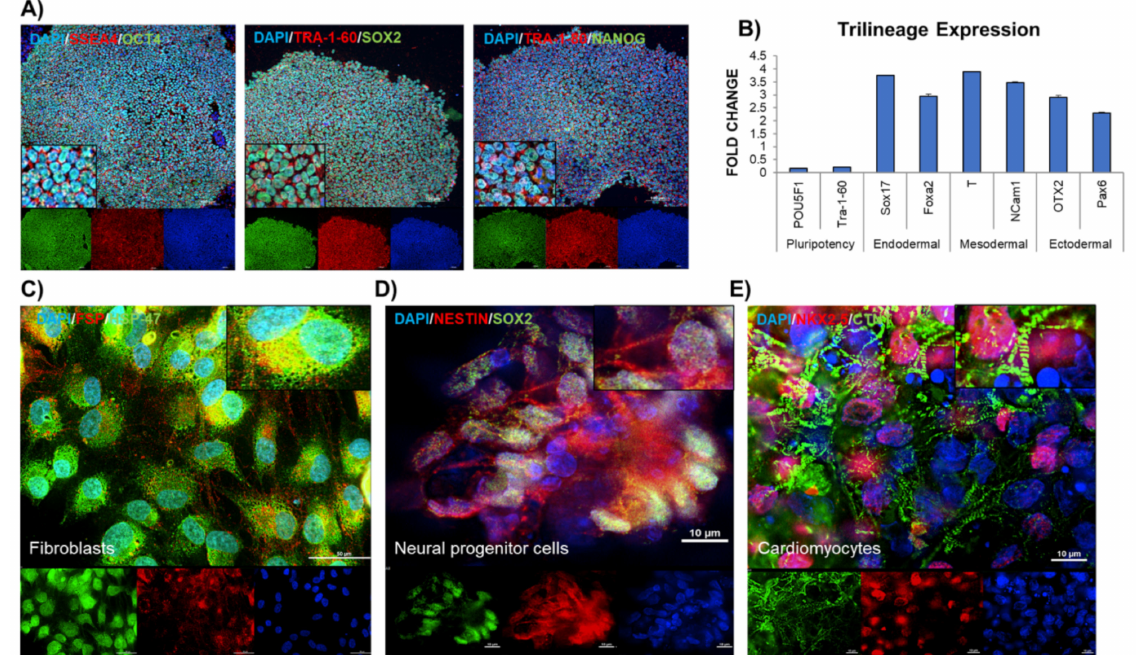
Figure 2. Characterization of pluripotency and differentiation potential of induced pluripotent stem cells (iPSC). ( A ) Characterization of the pluripotency was carried out by immunostaining of the pluripotency markers—SSEA4, TRA- 1-60, TRA-1-81 in red and OCT4, SOX2, NANOG in green. ( B ) Assessment of tri-lineage differentiation potential of iPSC was carried out by initiation of spontaneous differentiation by embryoid body generation. The embryoid bodies in suspension cultures differentiate into cells from all the 3 germ layers. These were detected by qPCR by targeting early lineage specific markers— POU5F1 and TRA-1-60 (pluripotency), SOX17 and FOXA2 (Endodermal), BRACHURY T or T and NCAM1 (Mesodermal), and OTX2 and PAX6 (Ectodermal). ( C - E ) The pluripotency was also characterized by cell specific differentiation, ( C ) Fibroblasts (immunostained for HSP47 (green) and FSP (red)), ( D ) Neural progenitors (immunostained for NESTIN (red) and SOX2 (green)) and ( E ) Cardiomyocytes (immunostained for NKX2.5 (red) and cTNT (green)), Nucleus is blue with Dapi. n = 3, each experiment was repeated 3–4